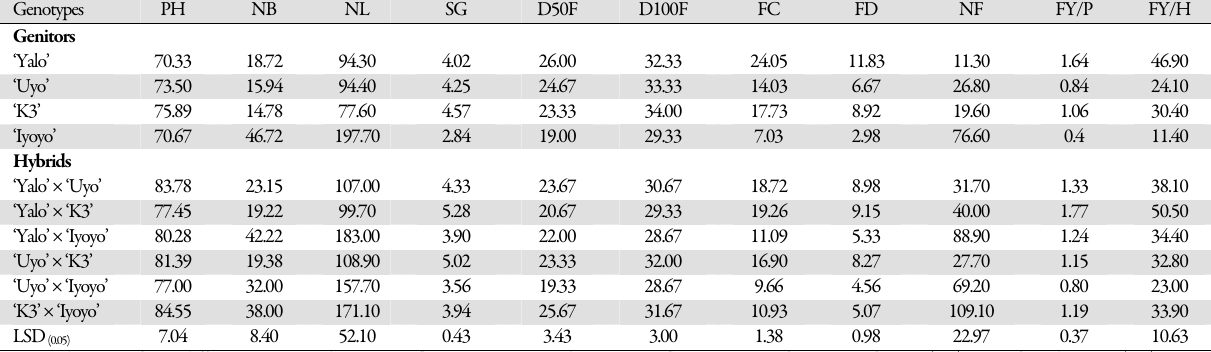
Table 1. Mean performance on the agronomic traits of the genitors and F 1 eggplant genotypes Genotypes PH